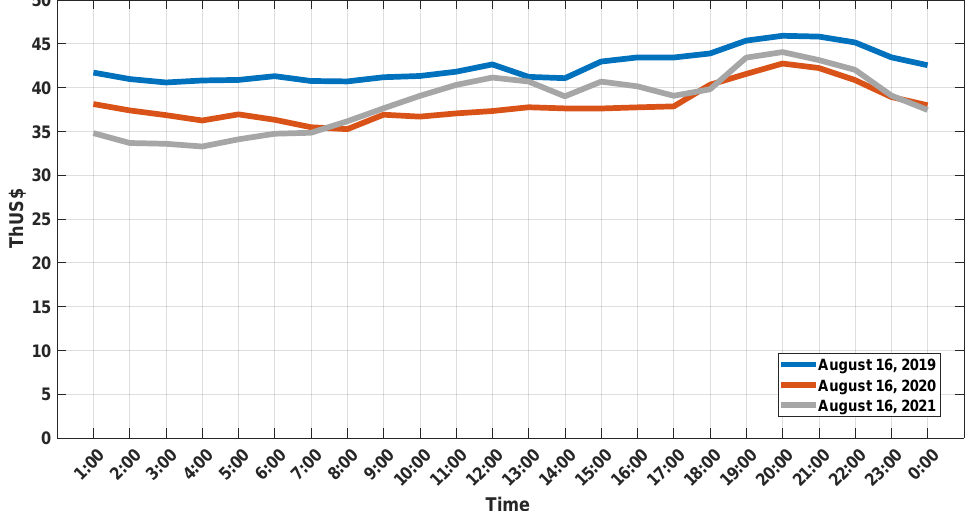
Figure 26. Variation of the optimal average cost of electricity by